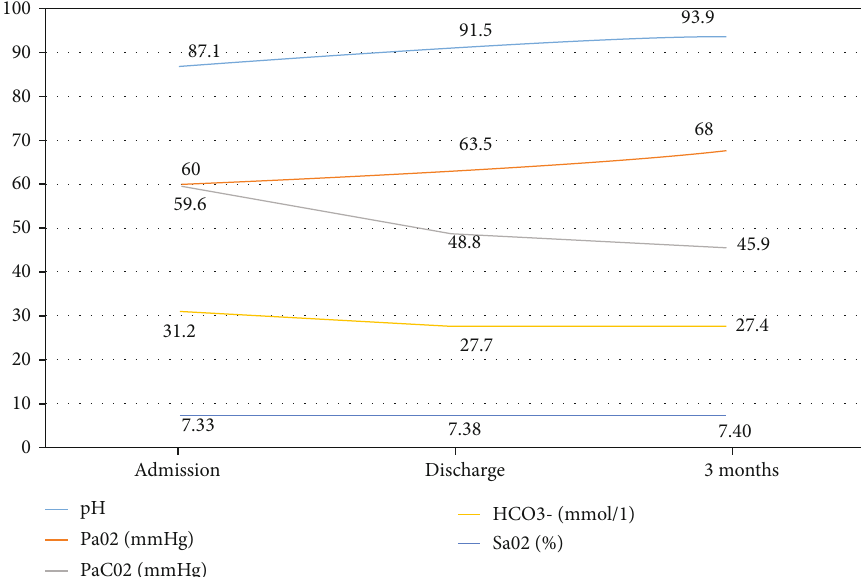
Figure 3: Arterial blood gases at the time of noninvasive positive pressure ventilation, at hospital discharge, and at 3 months follow-up after hospital discharge. PaCO : arterial partial pressure of carbon dioxide; PaO 2 : oxyhemoglobin saturation of arterial blood gas. bicarbonate in arterial blood; SaO 2